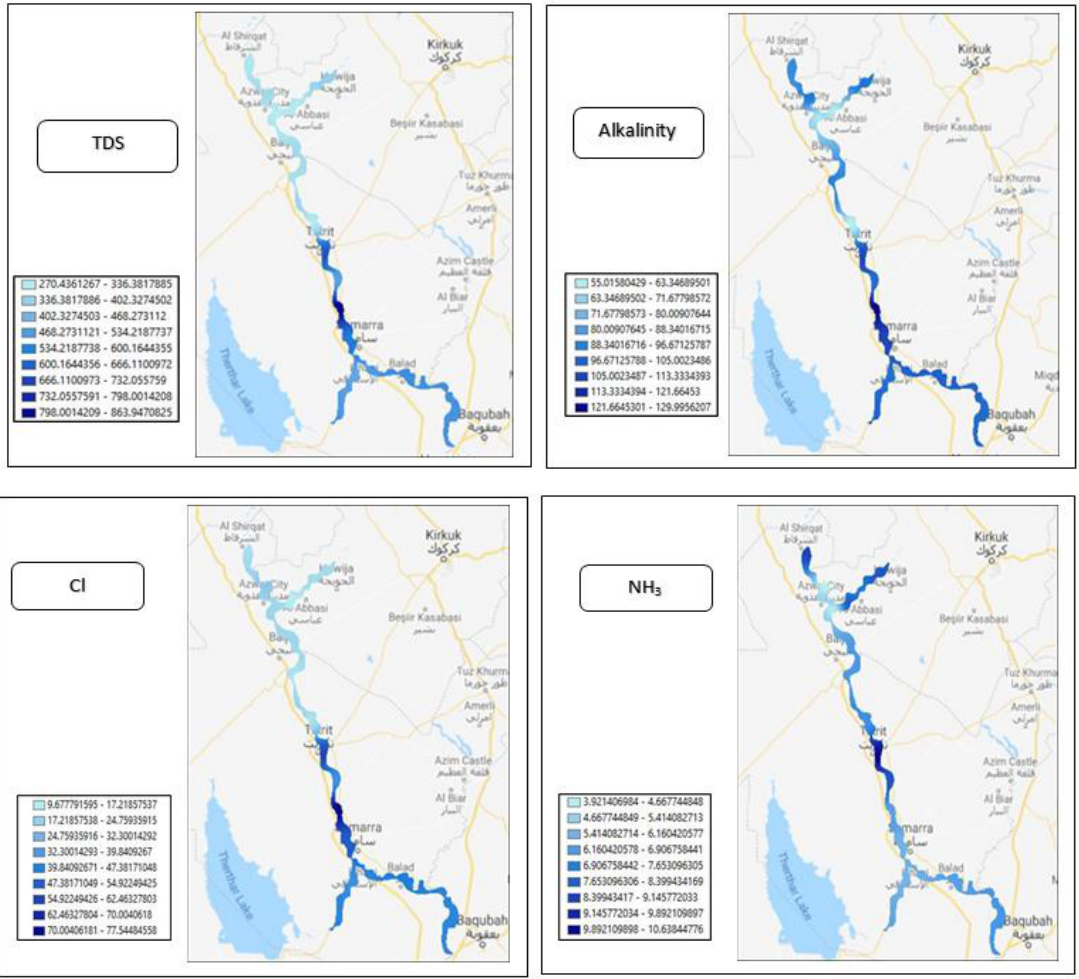
Fig.5: Spatial maps of concentration distribution for T.D.S, Alkalinity, Cl and NH